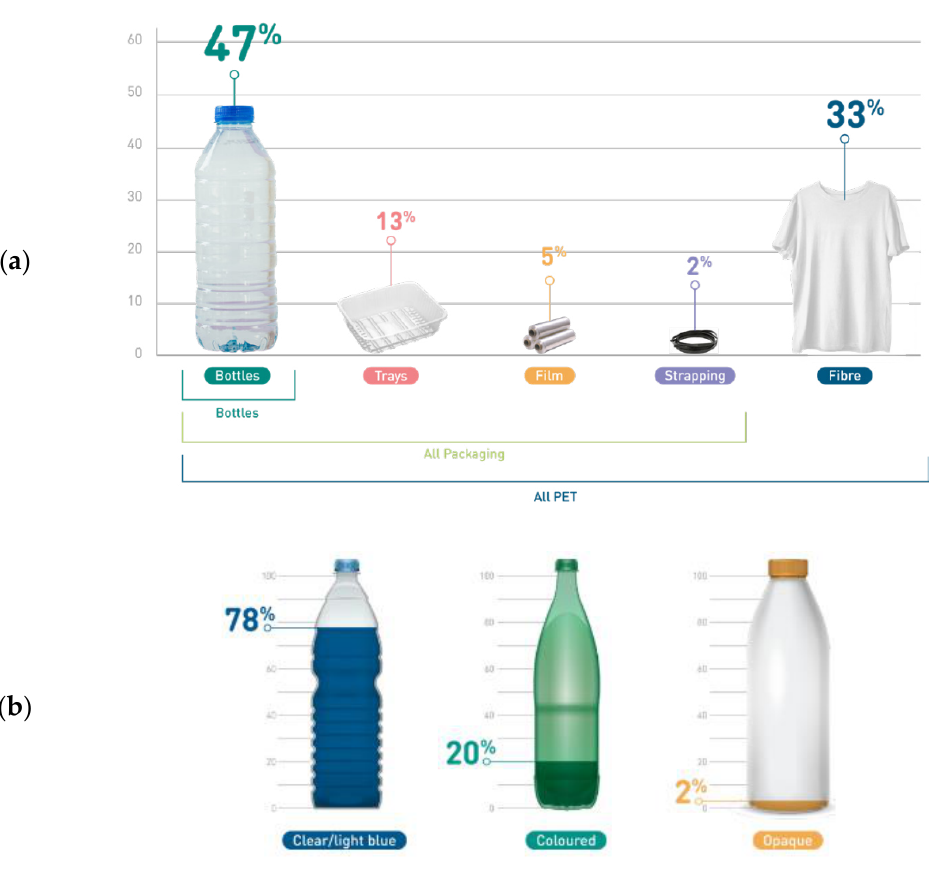
Figure 2. Market shares of PET ( a ) by manufacturing scope ( b ) by bottle types and colours—Reprinted with permission from Ref. [12].